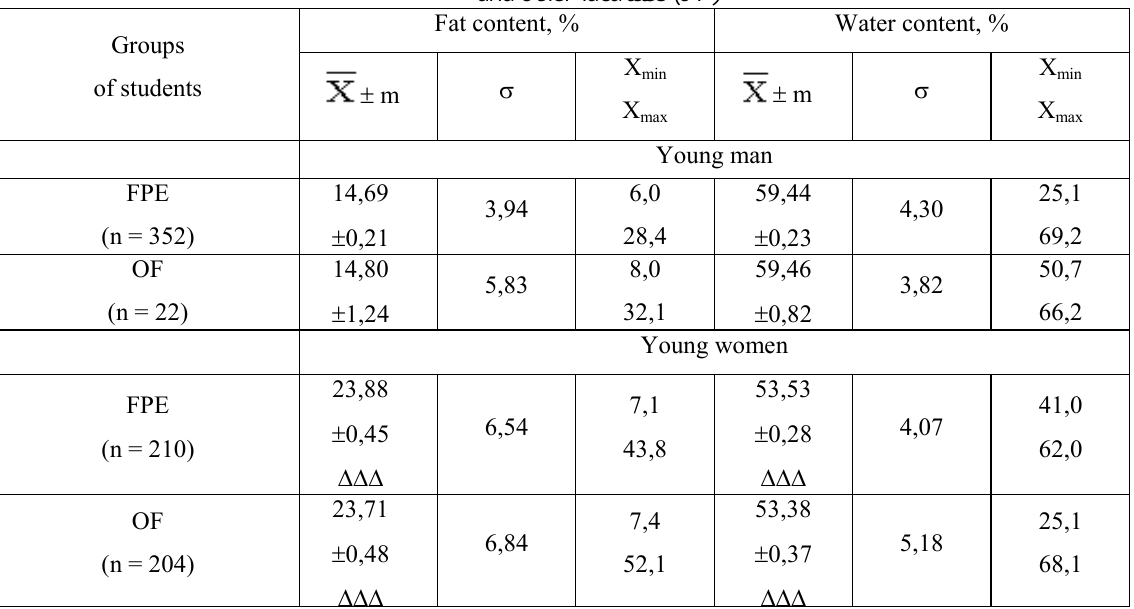
The percentage of fat and water in the body of young man and women studing in the 3-4th courses of the faculty of physical education (FPE) and other faculties